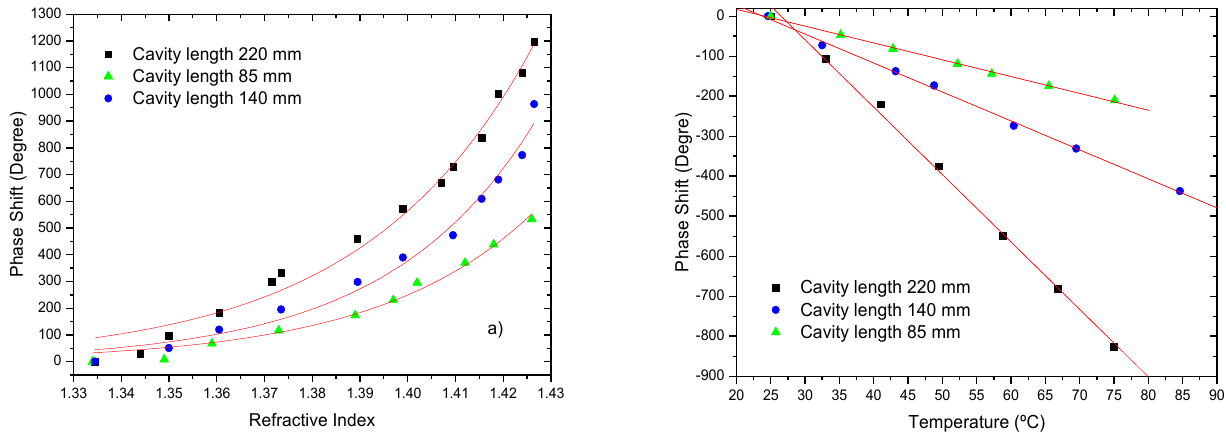
Figure 14. Interferometric phase changes for a 85 mm, 140 mm and 220 mm of sensing length (LPG at the 4th cladding mode): ( a ) due to refractive index variations; ( b ) due to temperature variations.